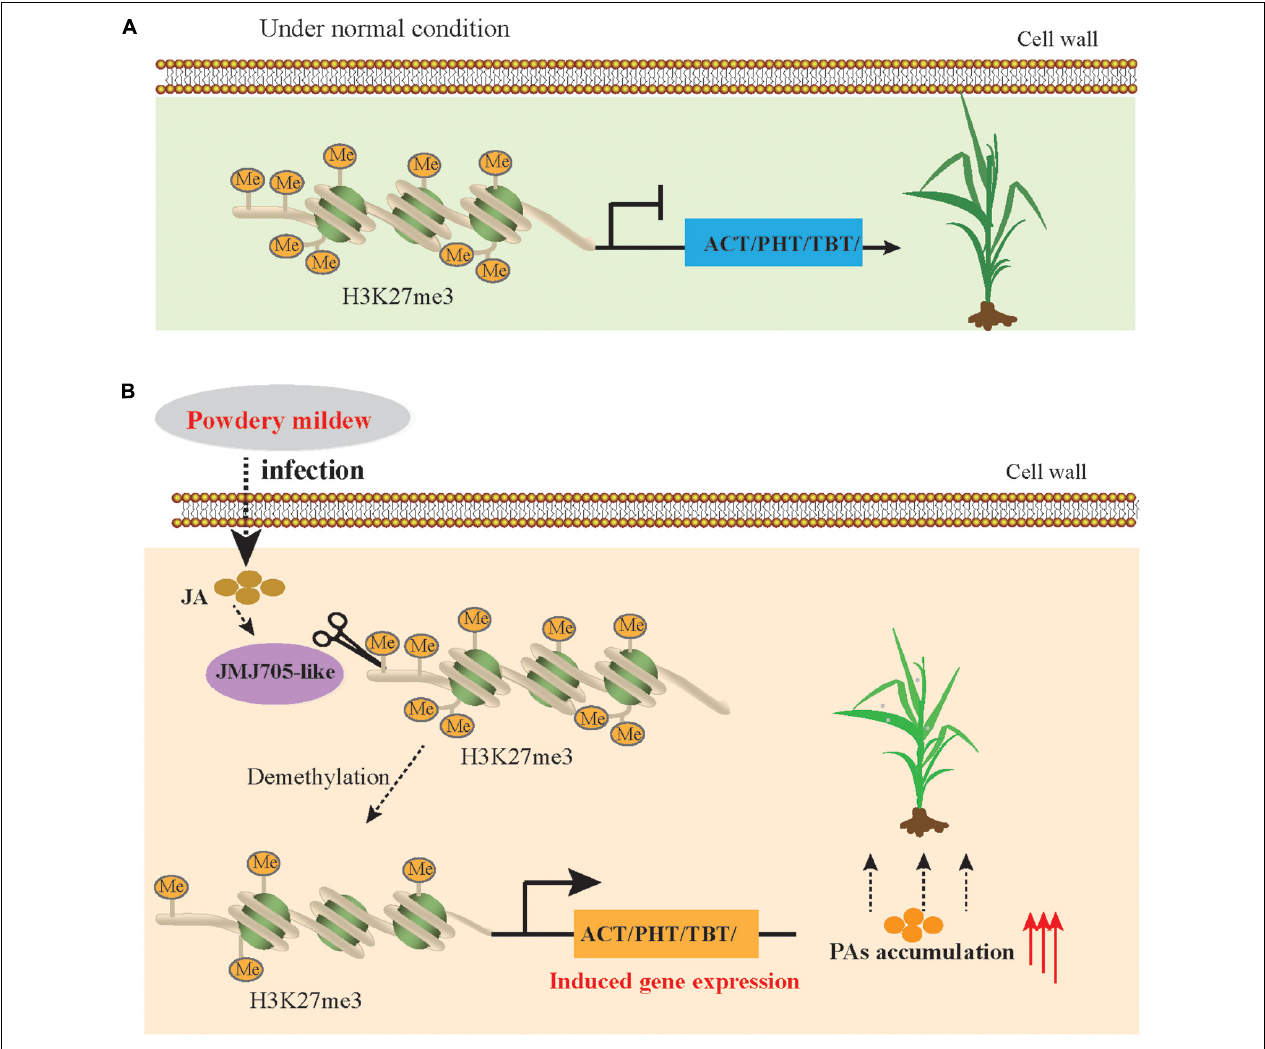
FIGURE 8 | Simplified model of JMJ705 like-mediated regulation of expression of BAHD N -acyltransferases to improve powdery mildew resistance. (A) In the normal condition, H3K27me3 level is enriched in BAHD N -acyltransferases due to the absence of demethylases, and the these genes expressions are repressed. (B) Under powdery mildew stress condition, DNA demethylases (JMJ705) activity is increased duo to JA level rapidly synthesis, resulting in reduced H3K27me3 level, induced BAHD N -acyltransferases expression and increased the biosynthesis of PAs to against the powdery mildew